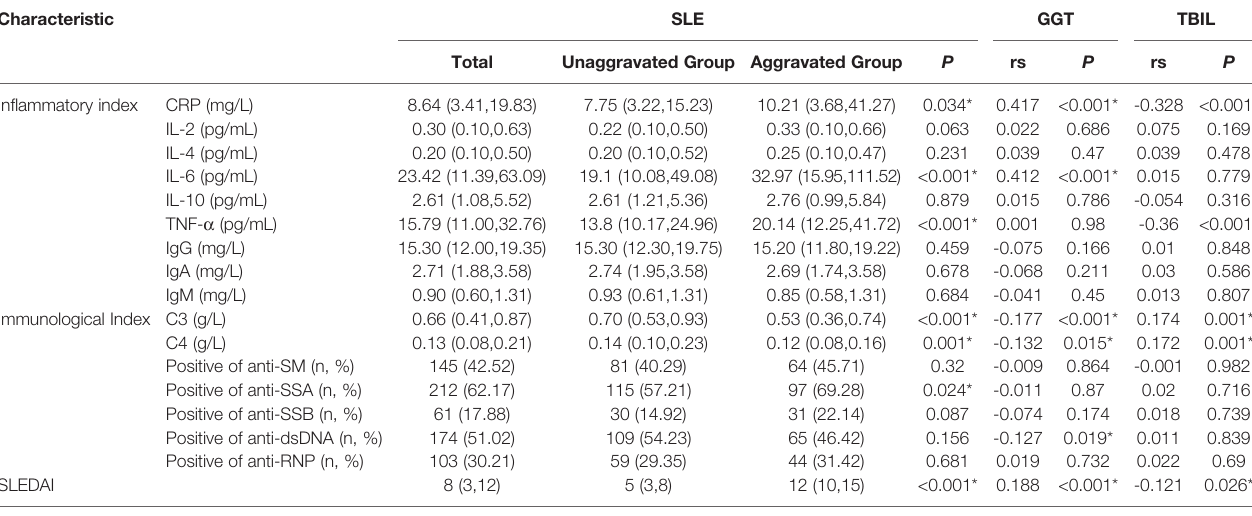
TABLE 2 | In fl ammatory and Immunological index in SLE patients. Characteristic